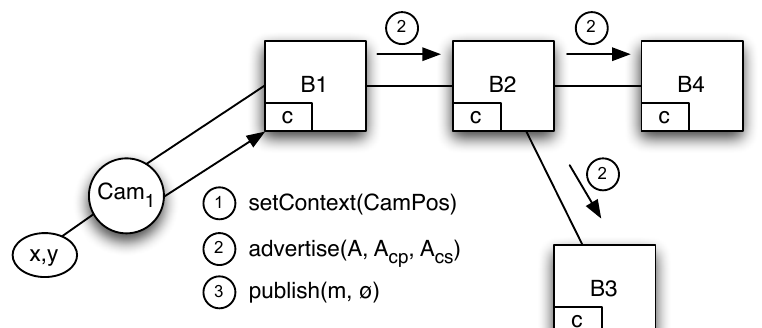
Figure 12. Adding a new publisher to the